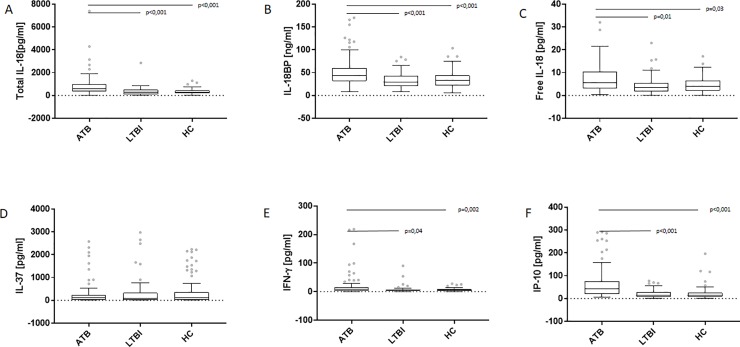
Serum levels of total and free IL-18, IL-18BP, IL-37, IFN-γ and IP-10 in the groups of the study.Boxplots with median (horizontal line within the box), interquartile range (box limits), and extremes (whiskers) of serum levels of total IL-18 (A), IL-18BP (B), free IL-18 (C), IL-37 (D), IFN-γ (E) and IP-10 (F) in the groups of patients with active tuberculosis (ATB) and latent M.tb infection (LTBI) and healthy controls (HC).